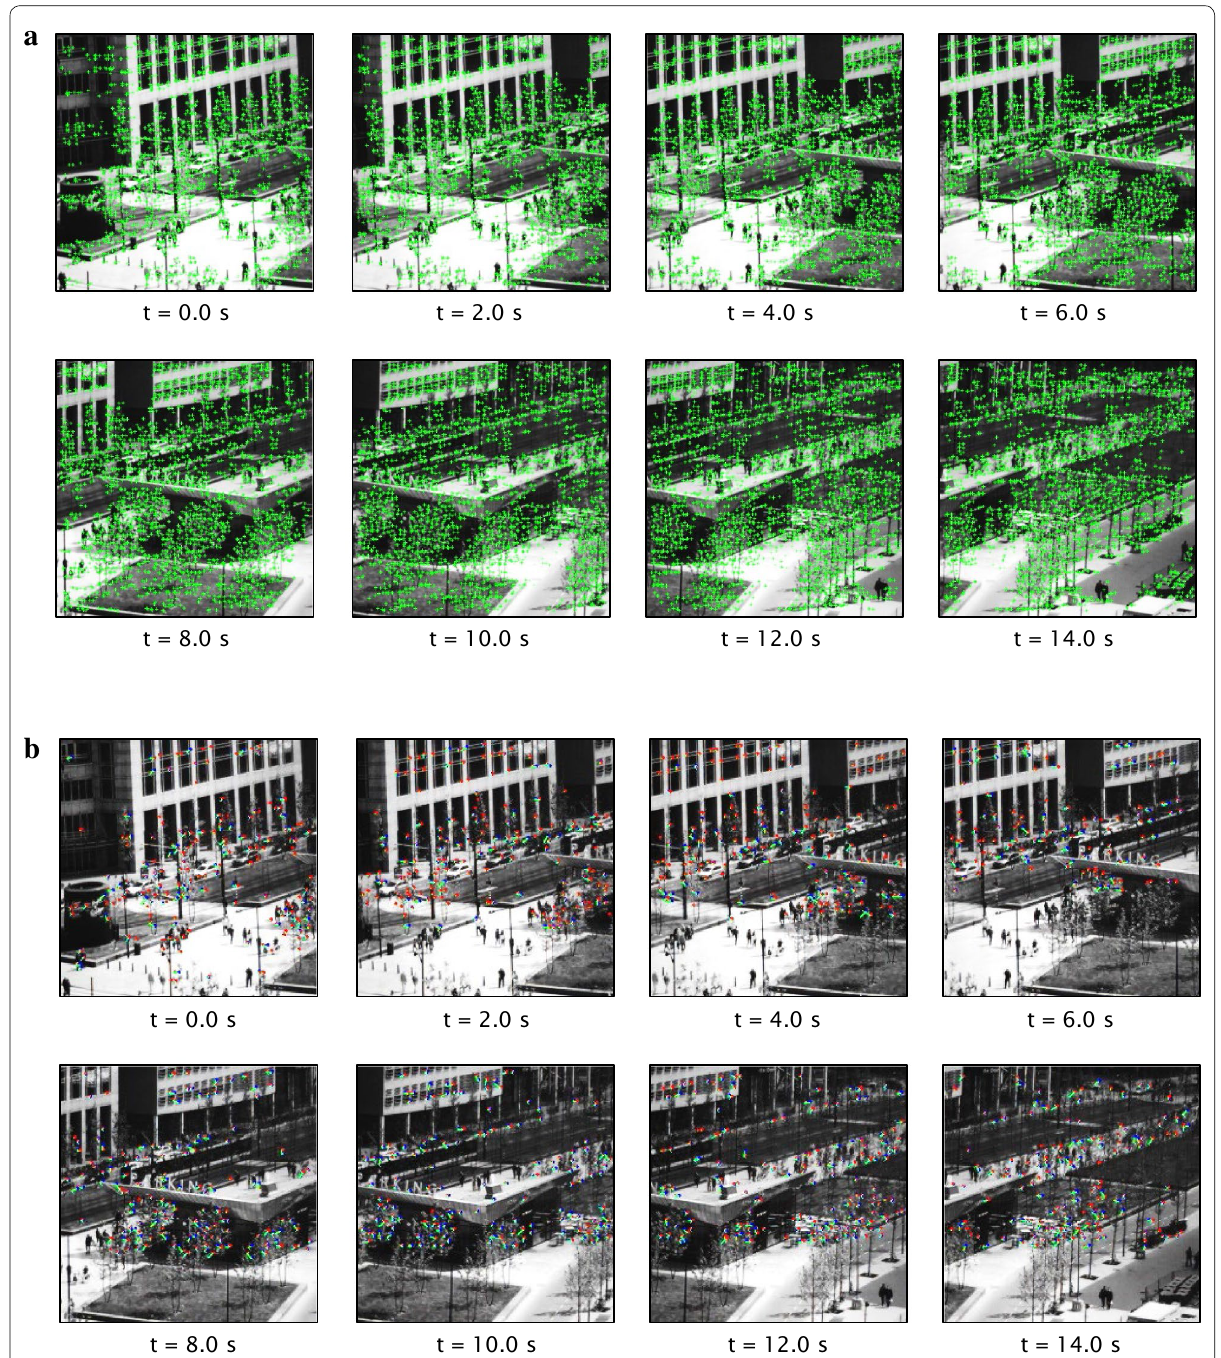
Fig. 10 Feature points plotted on 512 × 496 input images of camera 1 when observing a photographic pattern a extracted feature points, b pairs of matched feature